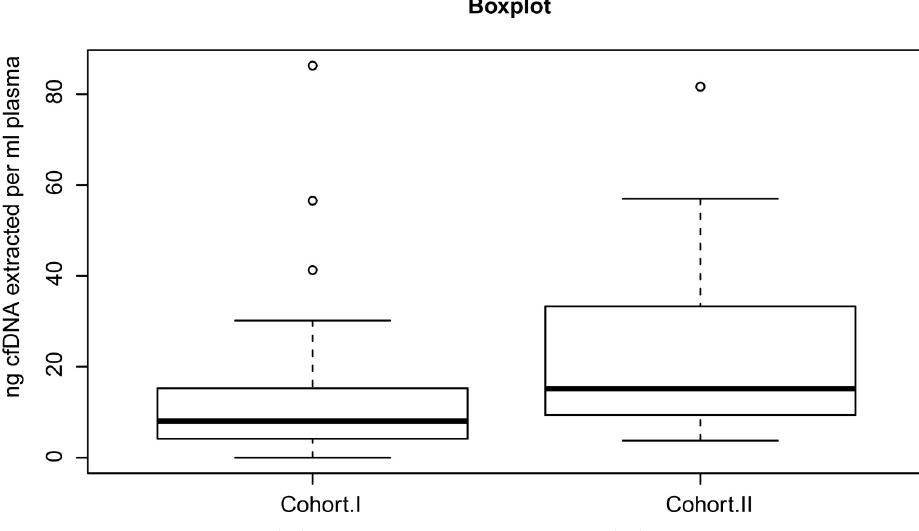
Fig 6. Distribution of nanogram (ng) total cfDNA extracted per milliliter (ml) plasma from patients in cohort I (N = 31) and cohort II (N = 34). The median amount of ng DNA per ml of plasma was 11.30 ng [2.33ng/ml;86.28ng/ ml] for cohort I and 15.19 ng [3.75ng/ml;81.67ng/ml] for cohort II, respectively.